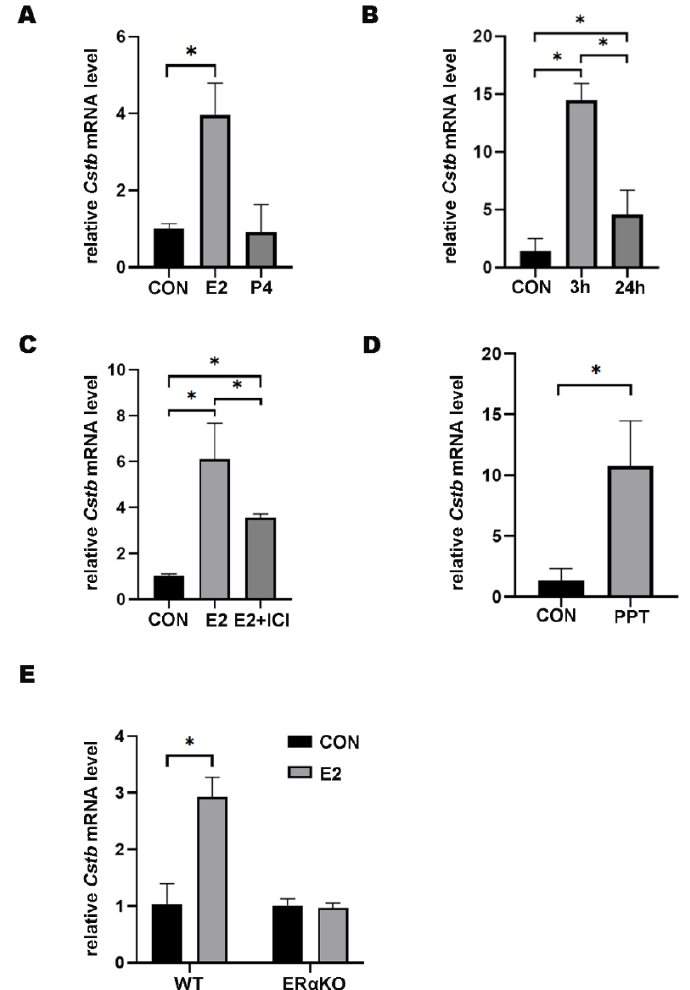
Figure 2. Regulation of Estrogen on Cstb Expression. ( A ) RT-qPCR analysis of Cstb expression in the uterus of ovariectomized mice treated with progesterone (1 mg per mouse) and estrogen (100 ng per mouse) for 24 h subcutaneously. ( B ) Cstb expression in the uterus of ovariectomized mice treated with estrogen was detected by RT-qPCR after 0 h, 3 h, 24 h, respectively. ( C ) Effect of ICI182780 on Cstb expression in ovariectomized mice after 3 h of estrogen stimulation. ( D ) RT-qPCR analysis of Cstb levels after ovariectomized mice were treated with PPT for 3 h. ( E ) Ovariectomized ER α knockout mice and ovariectomized wild-type mice were injected with sesame oil or estrogen, respectively, for 3 h, and the expression of Cstb was detected by RT-qPCR. CON, control; ER α KO, ER α knockout mouse; WT, ER α wild-type mouse; E2, estrogen; P4, progesterone; ICI, ICI182780; PPT, propyl pyrazole triol. * p < 0.05.